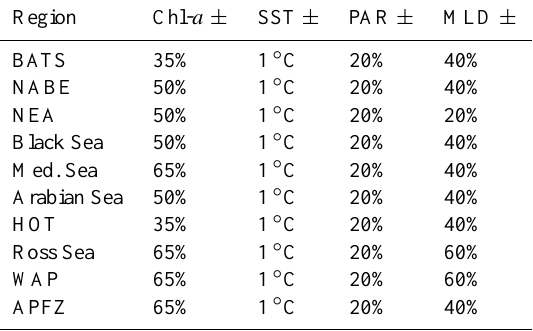
Table 3. Uncertainties in each input variable at each region based on differences between satellite, modeled, and in situ data sources. Ocean color models were provided with 81 perturbations of input data for each NPP measurement based on these region-specific un-